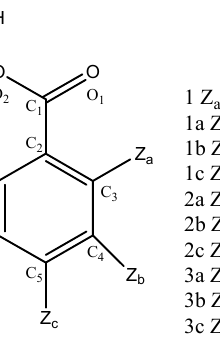
Figure 1. Substituted benzoic acids.